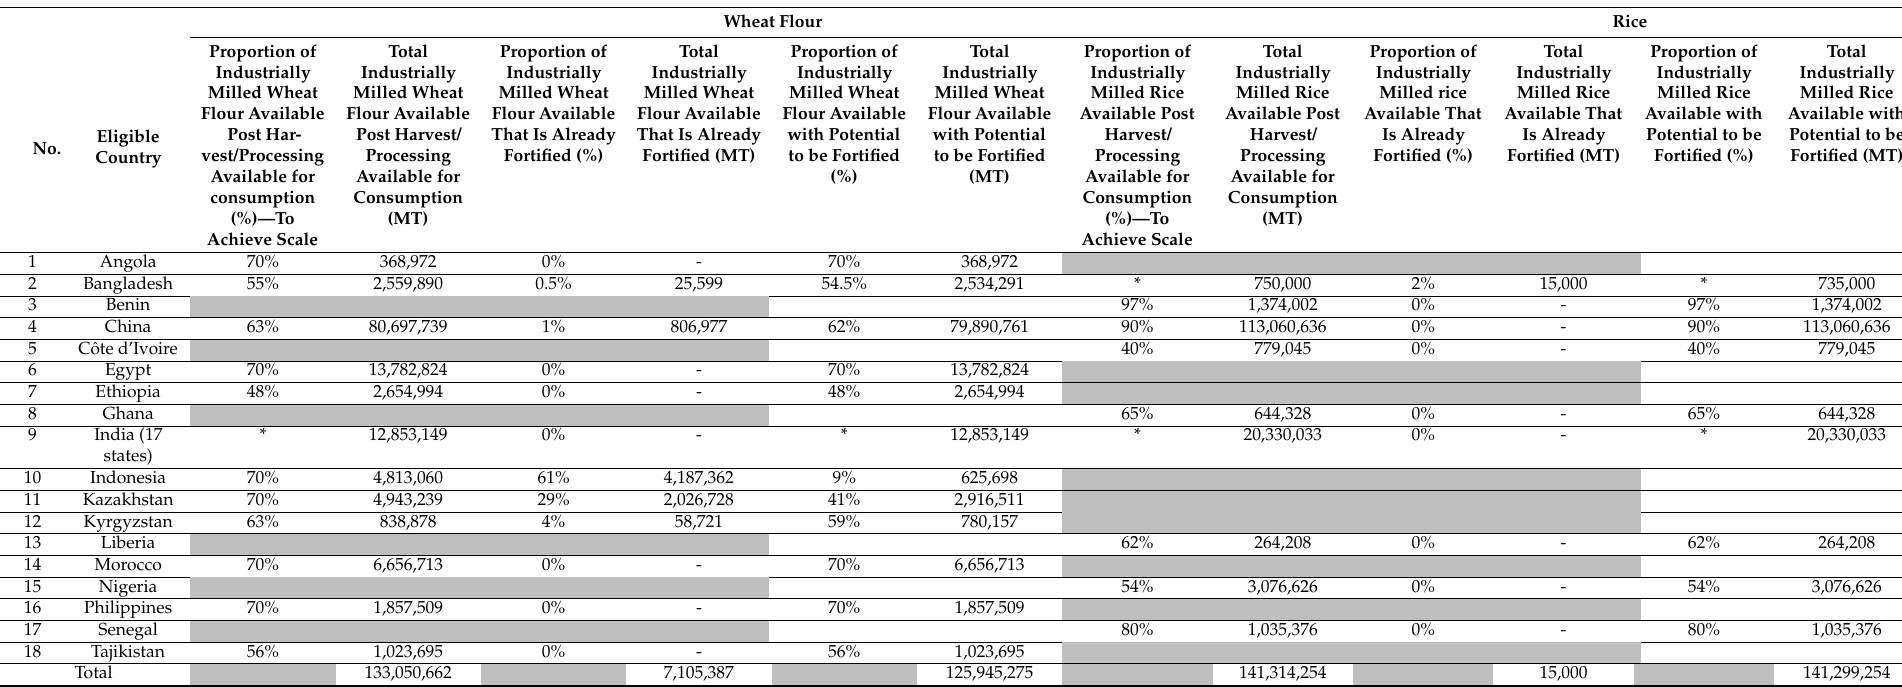
Table 5. Proportion and amount of industrially milled wheat flour and rice available for fortification in each eligible